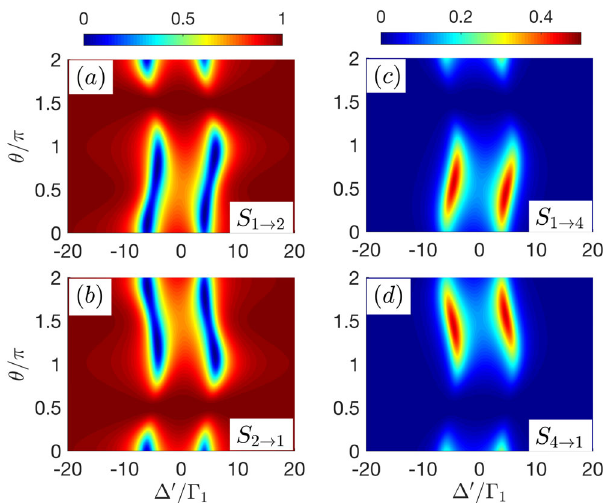
Fig. 6 Nonreciprocal scattering behaviors in a three-level ∇ -type giant- atom system. Scattering probabilities a S 1 → 2 ; b S 2 → 1 ; c S 1 → 4 ; d S 4 → 1 versus the detuning Δ 0 and the coupling phase difference θ . Other parameters: atomic dissipation rates γ ¼ γ ¼ 0, the ratio of two atomic emission e 1 e 2 rates into different waveguides Γ 2 / Γ 1 = 1, Rabi frequency of the external coherent fi eld Ω = 5 Γ 1 , and accumulated phase of the photon traveling in waveguide W a ϕ a 0 = π